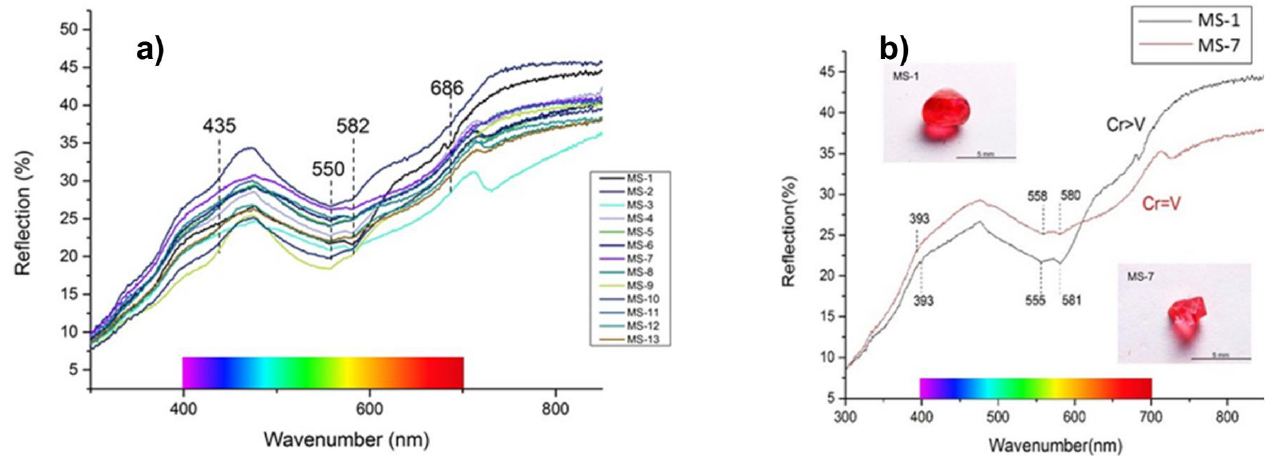
Figure 6. ( a ) UV-Vis Spectrophotometer of ‘Jedi’ spinel from Man Sin; ( b ) UV-Vis spectrophotometer of MS-1 and MS-7.